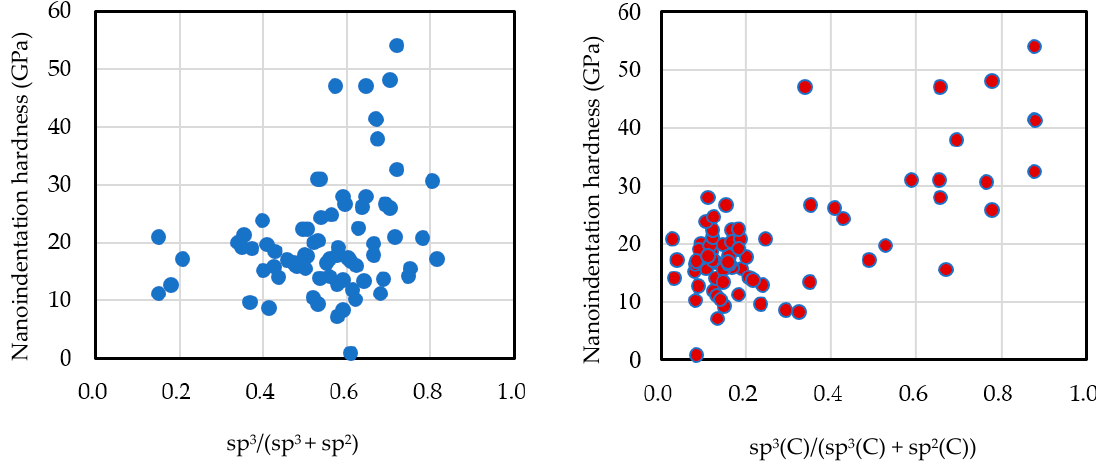
Figure 13. Nanoindentation hardness vs. sp 3 ratio (a) and sp 3 (C) ratio.